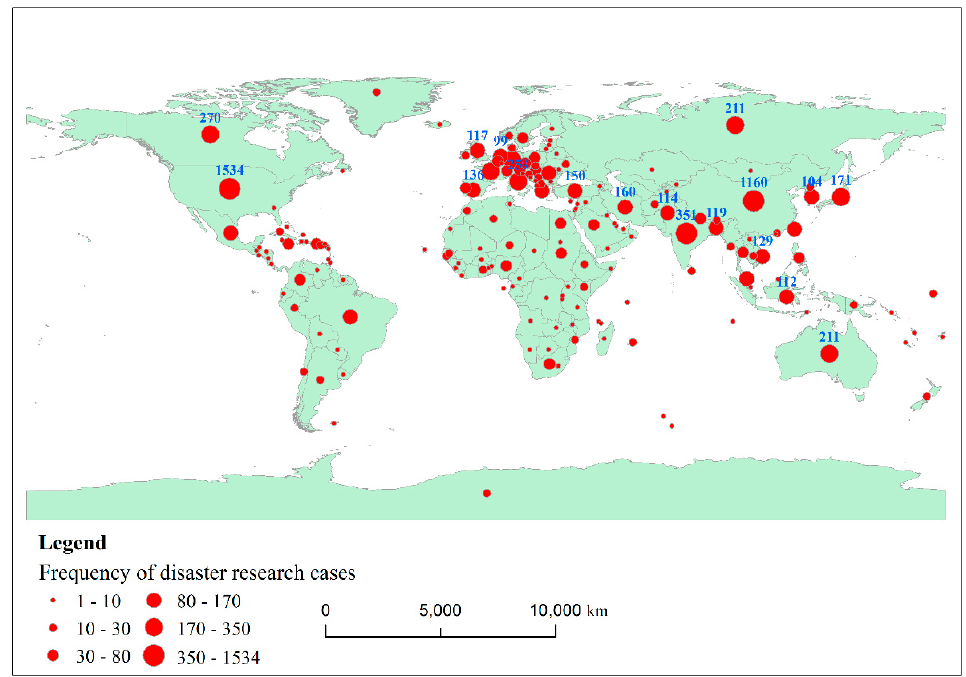
Figure 3. Spatial distribution of hot flood disaster research areas (only the top 20 countries are labeled).